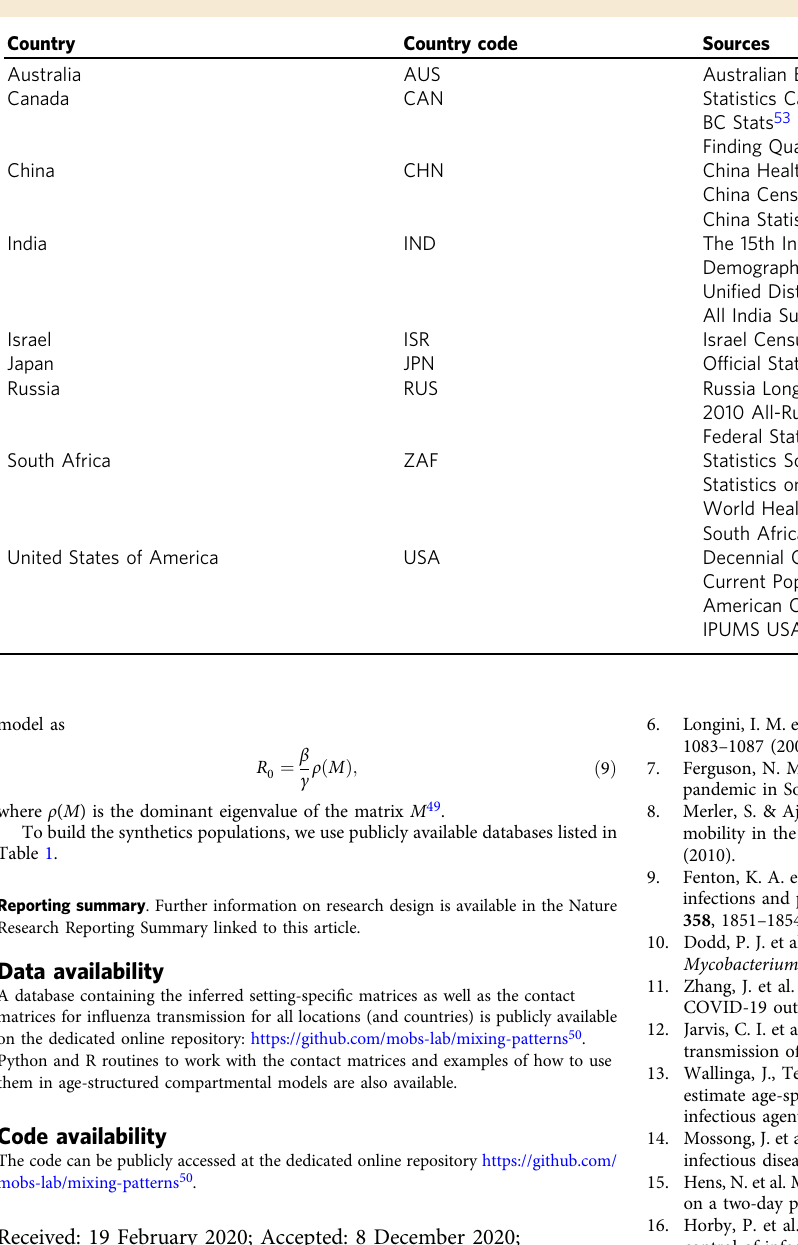
Table 1 Data sources for each country and the country